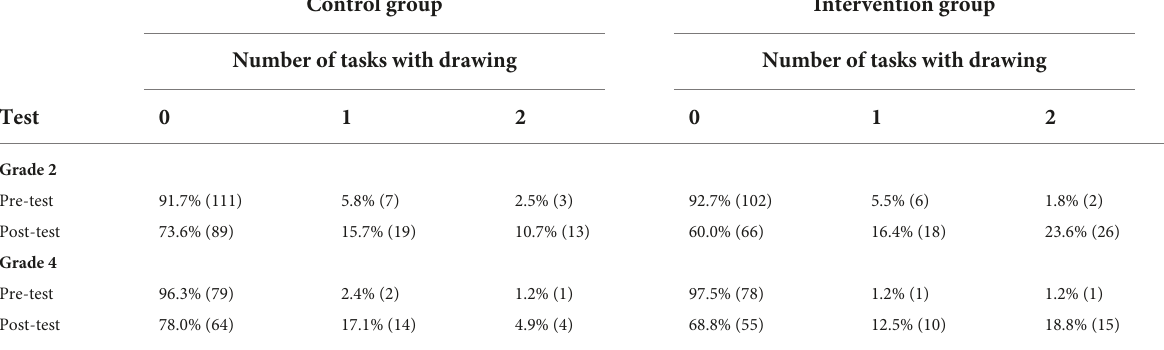
TABLE 1 Percentage and (number) of drawings in intervention and control groups in pre- and post-tests. Control group Intervention group Number of tasks with drawing Number of tasks with drawing